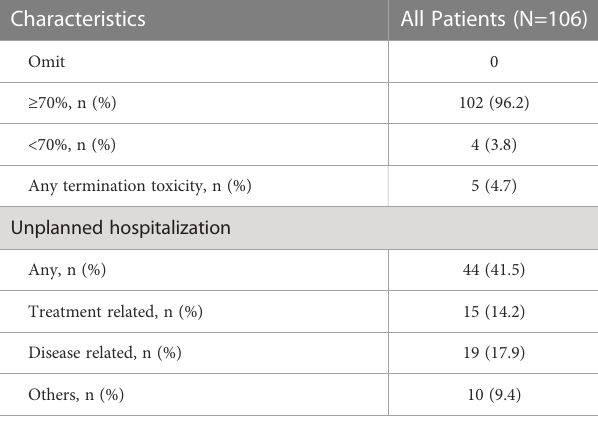
TABLE 2 Patients who received conversion chemotherapy for liver-only disease, 2019 – 2021 (N =